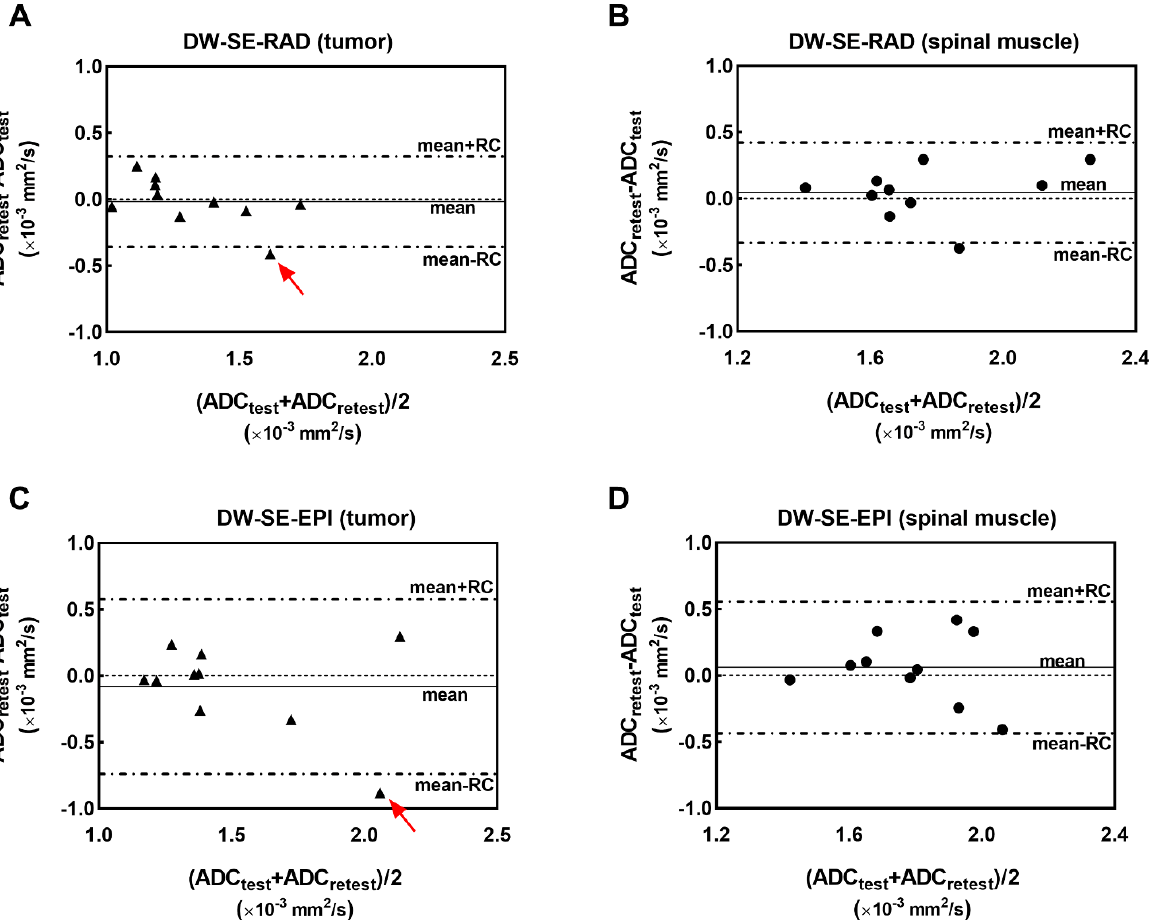
Figure 4. Bland-Altman plots of the tumor ( A , C ) and muscle ( B , D ) ADC measurements obtained from the test–retest experiment for each DWI protocol. The mean of ∆ ADC and mean ± RC are specified in the figure, while the RC values are reported in Table 1. Red arrows point to the worst cases in each DWI protocol. ∆ ADC = ADC test − ADC retest , RC is repeatability coefficient defined in Equation [4].